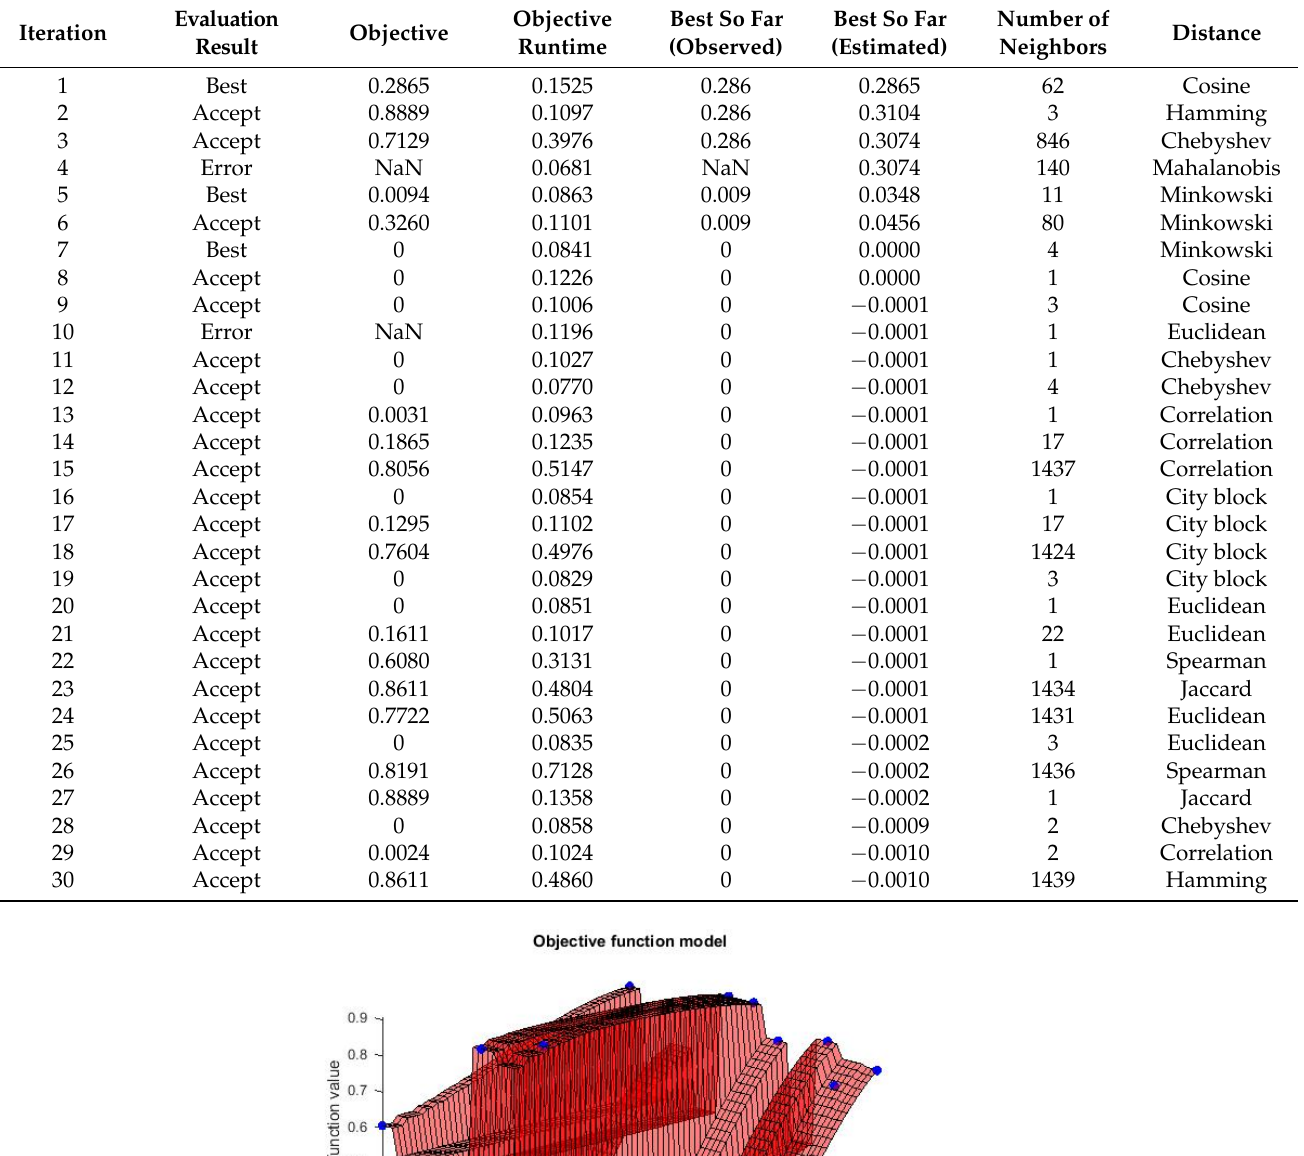
Table A4. Hyperparameter optimization results for the k-NN classifier trained for the first mode of the second learning scheme (a higher precision of localization).